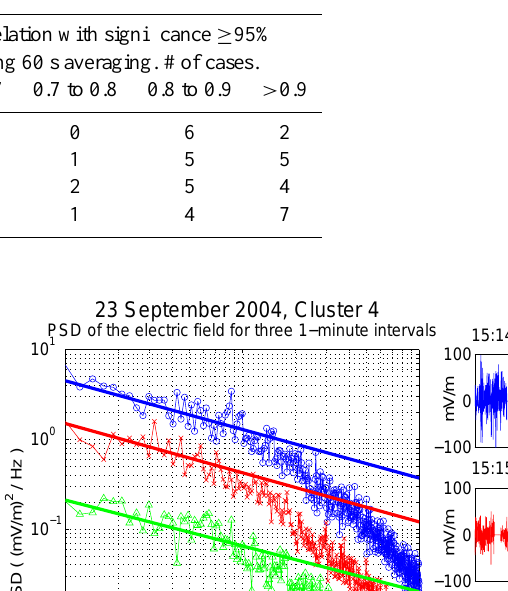
Table 3. Each row shows a summary of the correlation coefficients of the Power Spectral Density (PSD) of the electric field fluctuations around 1Hz versus one type of ion flux, with each column containing the number of cases with a correlation within the interval shown in the column header. 60s averages of the wave power and flux levels were used for the calculations. Only correlation coefficients with a significance level of 95% or greater are included in this table. “field-aligned” flux is the sum of the absolute values of upward and downward flux.